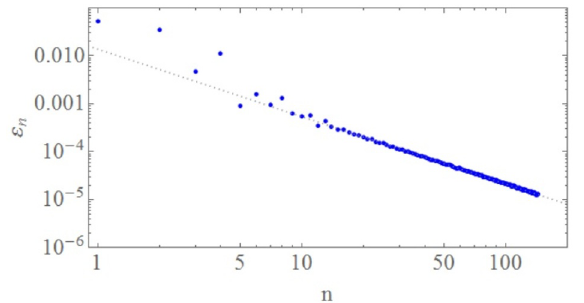
Figure 11 . Energy spectrum right before the formation of the first cusp pair. A power-law fit gives ε − 1 . 41 ± 0 . 05 . The parameters were ∆ t = 8 , (cid:15) = 0 . 07 , N n ∝ n